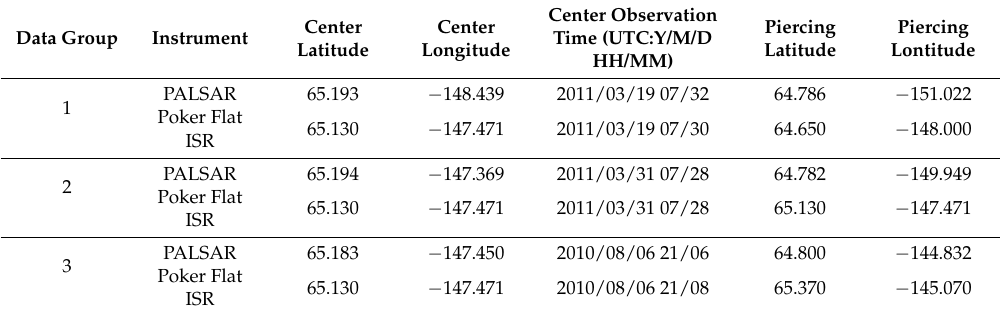
Table 1. Corresponding observing times and positions of three groups of data. The off-nadir angle of PALSAR (Phased Array type L-band Synthetic Aperture Radar) in this table is 21.5 degrees. ISR: Incoherent Scatter Radar.